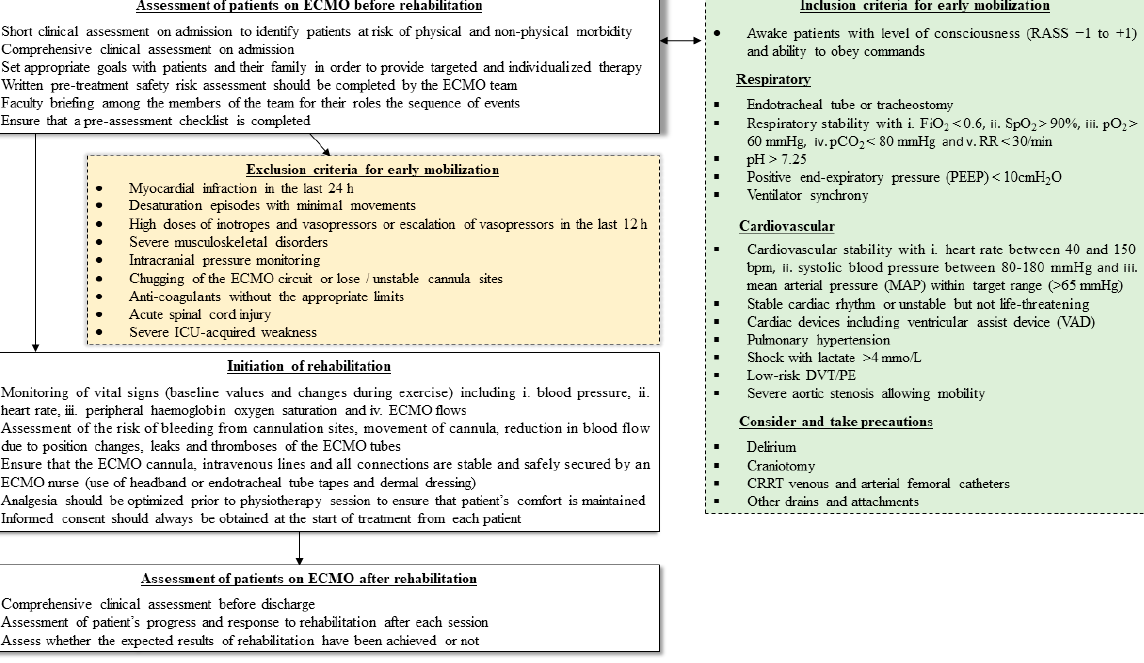
Figure 1. Screening and assessment of critically ill patients on ECMO support prior, during and after rehabilitation [48]. ECMO, extracorporeal membrane oxygenation; RASS, Richmond Agitation and Sedation Scale; RR, respiratory rate; DVT, deep vein thrombosis; PE, pulmonary embolism; ICU, intensive care